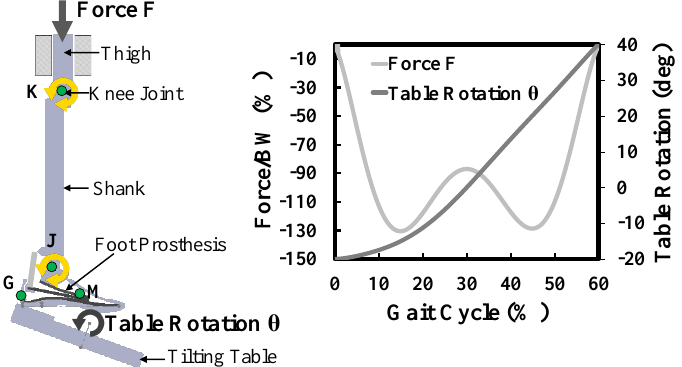
Tilting Figure 20. ISO–22675: the tilting table simulates the relative rotation between the ground and the thigh. The force F depends on the weight category and the maximum value was 130% of the body weight (BW). For the 60 kg weight category, the maximum value of the force F was 764 N. The tilting table ranged from − 20° to 40°.